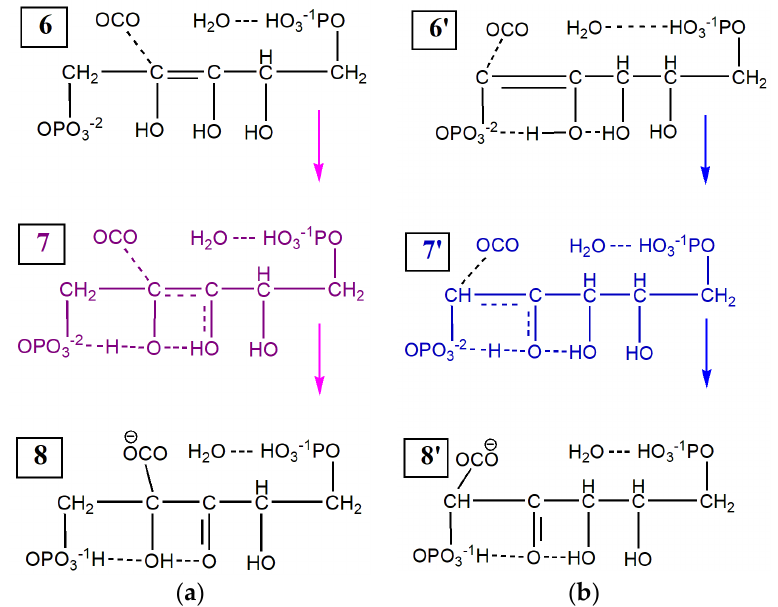
Figure 5. The scheme of carboxylation via C 1 (blue) and C 2 (purple) carbons in: ( a ) 1,2-enol + ⋅ H 2 O; ( b ) 2,3-enediol + ⋅ H 2 O. The initial states (6) and (6 ′ ) are preliminarily calculated at the stages of enolization. Their optimized geometric structures are shown in Figures A12 and A13, respectively. The states corresponding to the top of the barrier (7) and (7 ′ ) are colored. The products of carboxylation are as follows: 5-(hydrogen phosphonatooxy)-2-((hydrogen phosphonatooxy)methyl)-2,4-dihydroxy-3- oxopentanoate—the state (8) excluding water and 2,6-bis(hydrogen phosphonatooxy)-4,5-dihydroxy- 3-oxohexanoate—the state (8 (cid:48) ) excluding